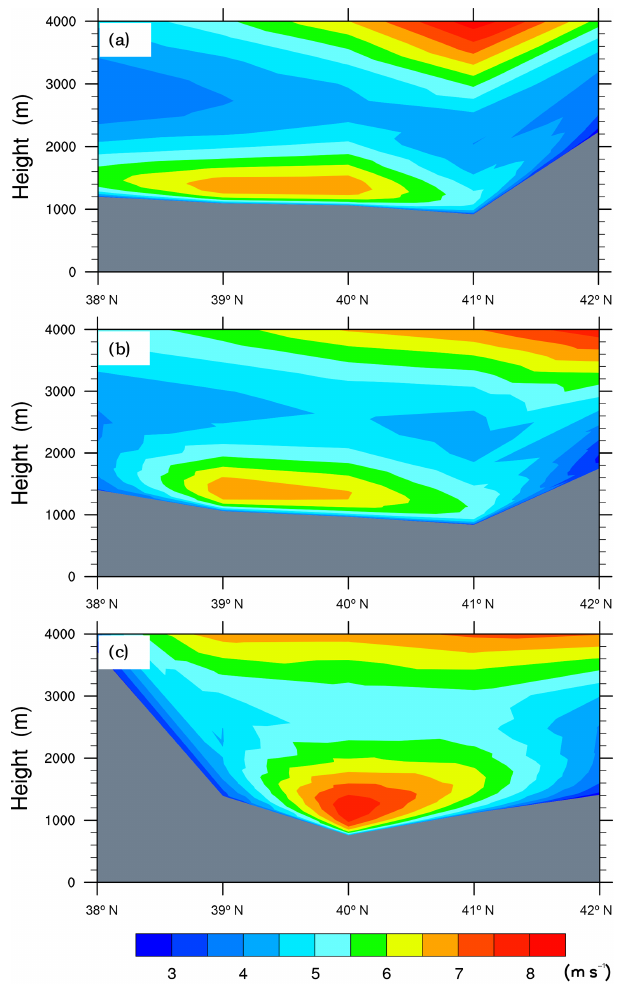
Figure 3. Latitude–height cross sections of annual mean wind speed at three longitudes of (a) 82 ◦ E, (b) 85 ◦ E, and (c) 88 ◦ E from ERA- Interim reanalysis averaged over 2000–2013. Gray areas represent the terrain elevation.